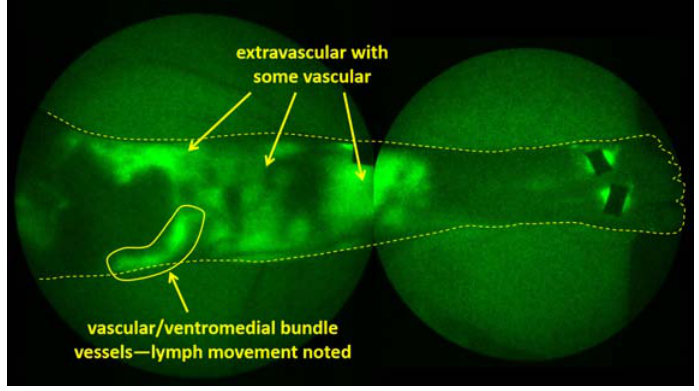
Note : Image shown is montage of smaller regional images. Fig. 6. NIRFLI image of subject 1's lower left anterior leg, after PCT treatment. Extravascular/di®use and vascular/linear dye/ lymph is visible. Ventromedial lymphatic bundle vessel is evident, and pumping through this vessel was